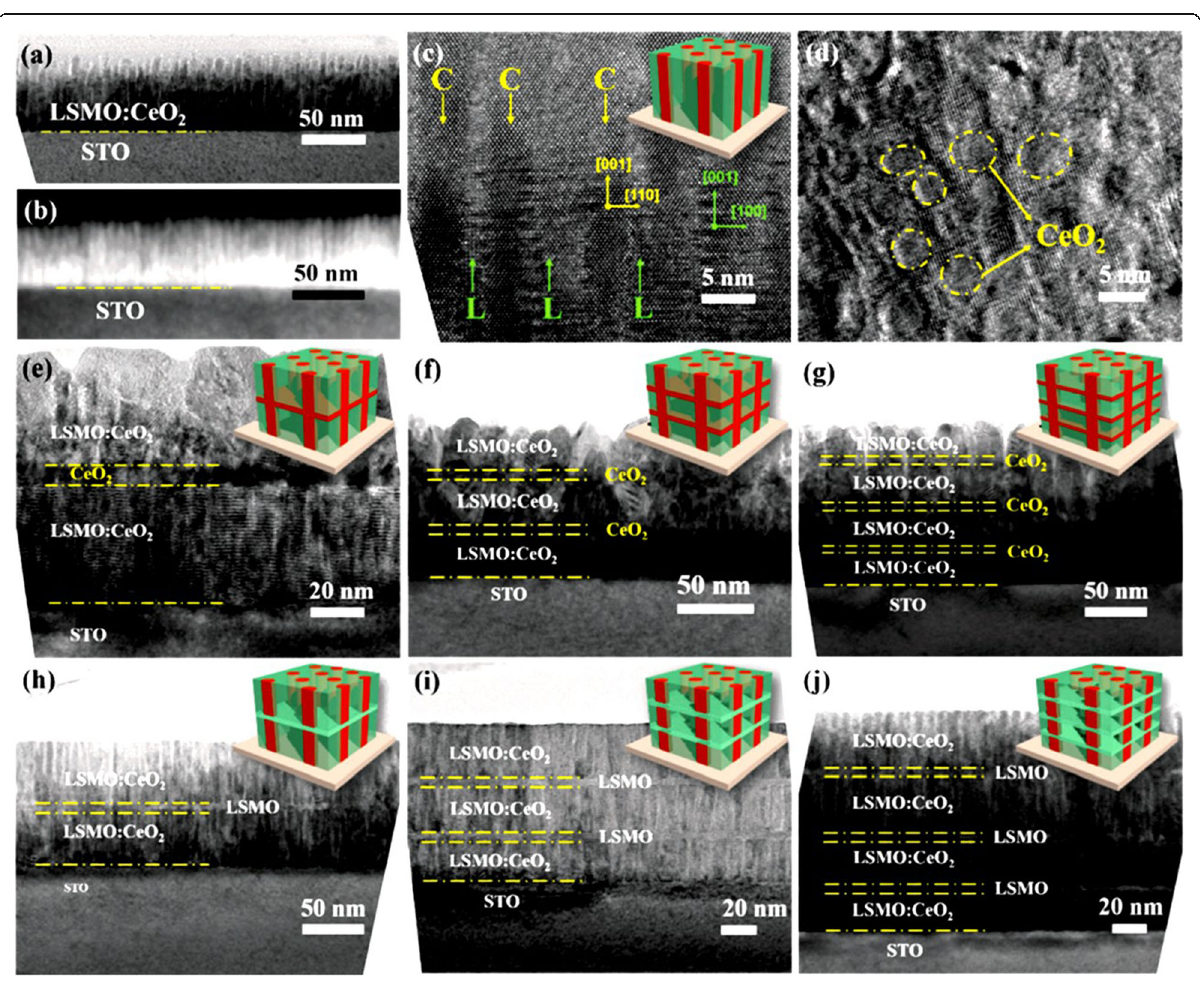
Fig. 18 a Cross-sectional TEM image of the VAN thin film C0 and b its corresponding STEM image at low magnification. c Cross-sectional and d plan-view HRTEM images of sample C0. In the HRTEM image of ( c ), “ C ” in yellow points out the CeO 2 nanopillars and “ L ” in green points out the La 0.7 Sr 0.3 MnO 3 (LSMO) matrix. Clearly, those CeO 2 nanopillars with a large aspect ratio are vertically aligned and well distributed in the LSMO matrix and the sharp phase boundaries suggest the well separated growth of the two phases. Cross-sectional TEM images of the thin films e – g C1 – C3 and h – j L1 – L3, showing the microstructures of 3D interconnected CeO 2 and LSMO frames embedded within the thin films